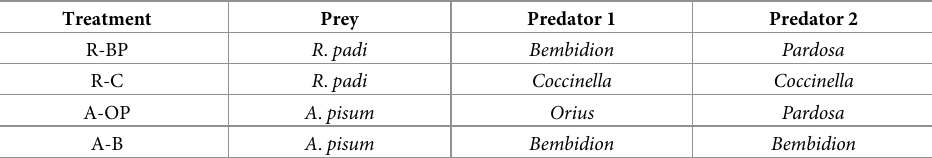
Table 3. Key for cage treatments referenced in Fig